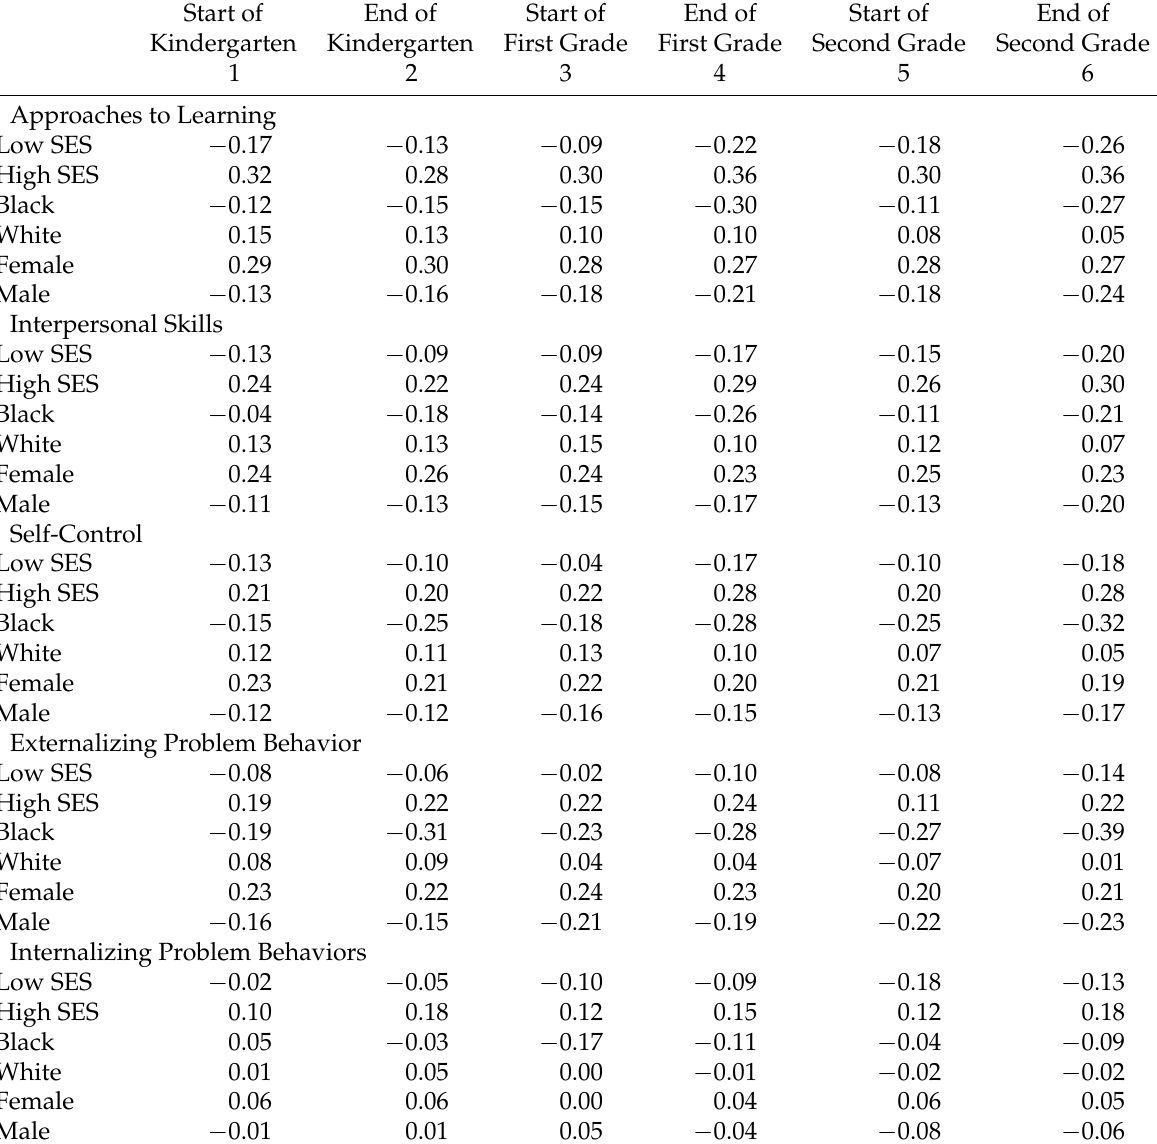
Table 1: Average social and behavioral skills by socioeconomic status, race (black or white), and gender from the start of kindergarten through the end of second grade (ECLS-K